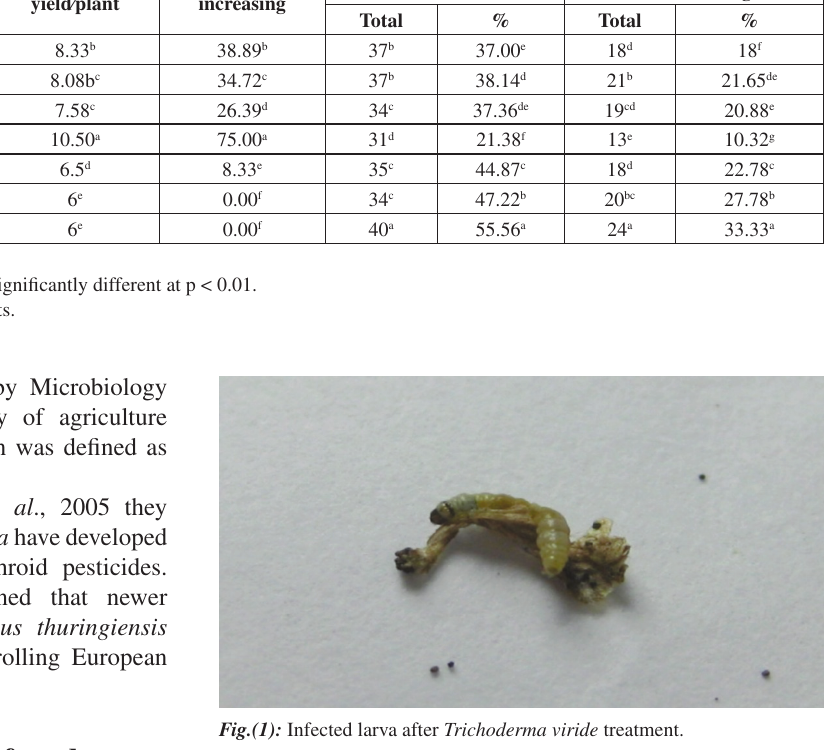
Table (2): The percentages of yield and infested tomato fruits under tested treatments in 2012 season.